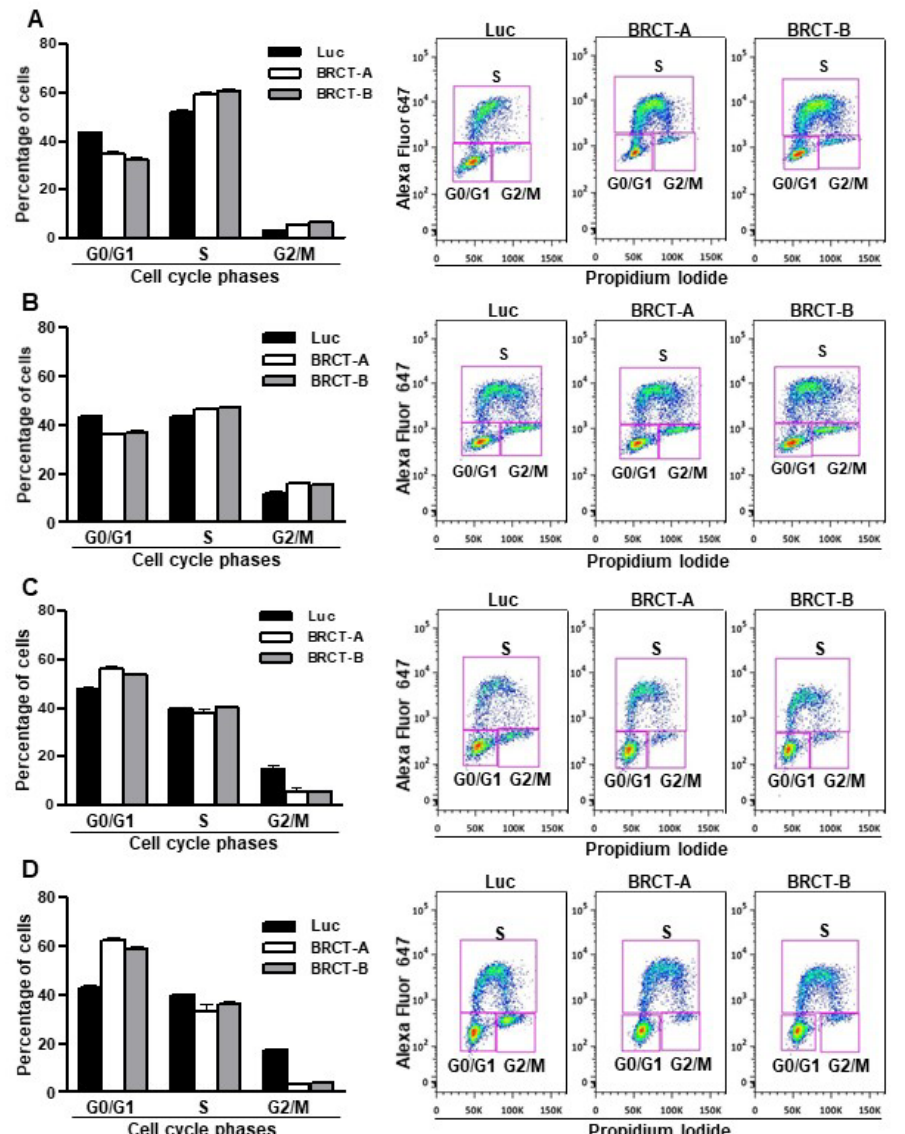
Figure 3. Effect of the expression of BRCT domain from LmjPES protein on cell cycle progression. Percentage of cells in the different phases of cell cycle and representative image of cell cycle analysis from HEK293T ( A ) and NIH/3T3 ( B ) infected cells with lentiBRCT (BRCT-A and BRCT-B) or lentiLuc (Luc). Percentage of cells in the different phases of cell cycle and representative image of cell cycle analysis from HEK293T ( C ) and NIH/3T3 ( D ) cells cultured in a limited nutrient medium and infected with lentiBRCT (BRCT-A and BRCT-B) or lentiLuc (Luc).